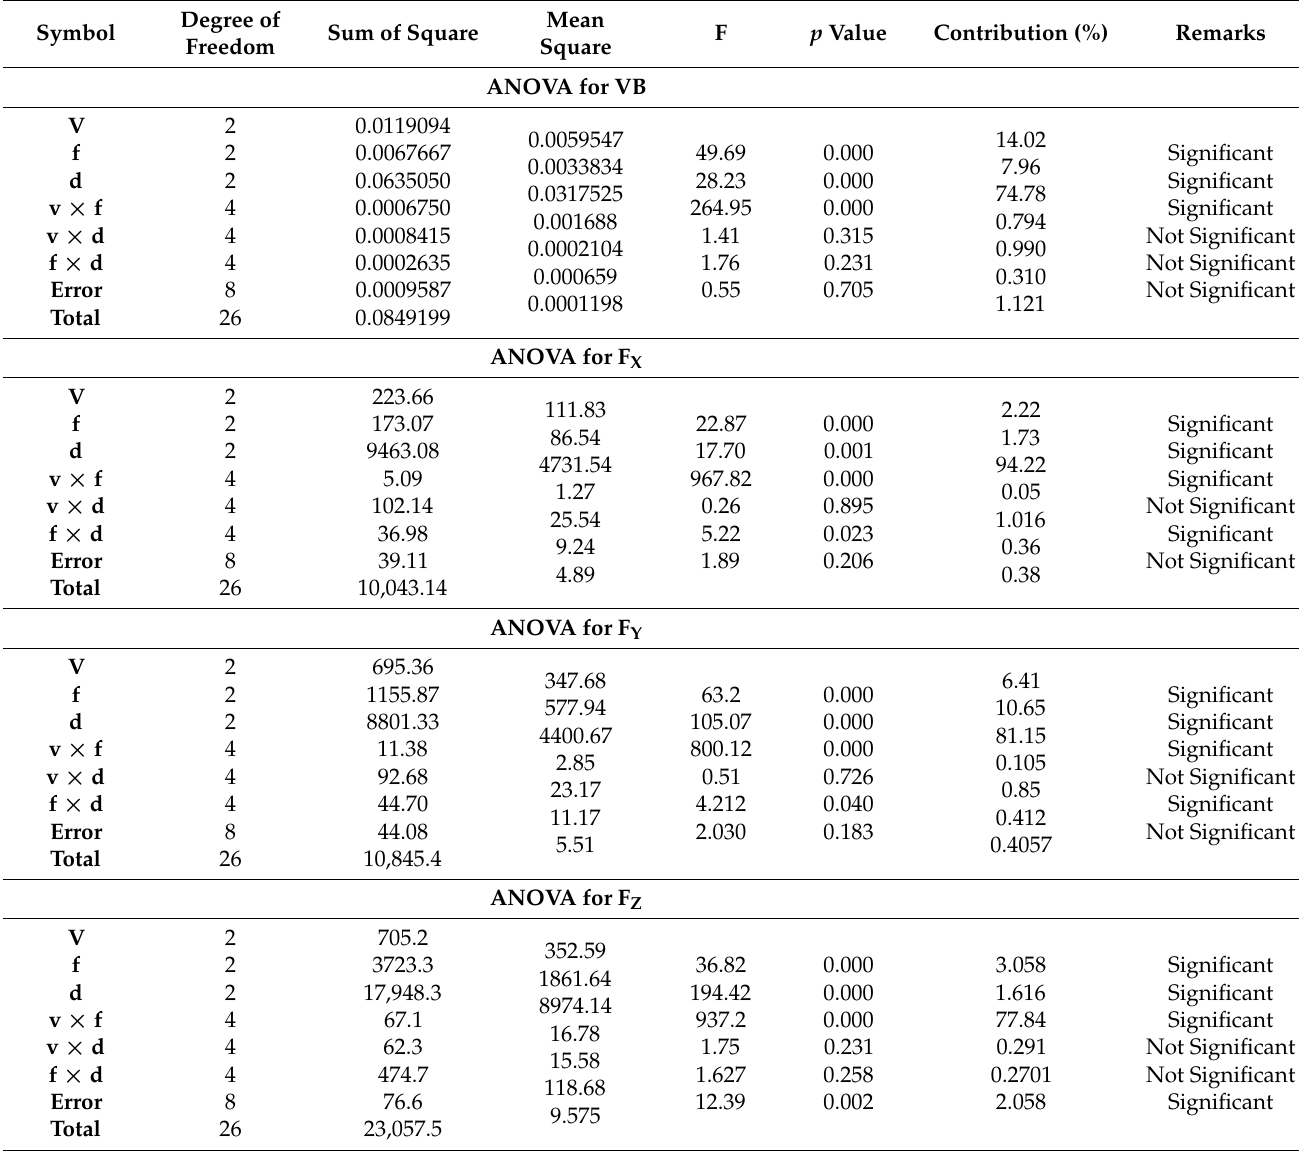
Table 4. Result of analysis of variance (ANOVA) for VB, F X , F Y and F Z